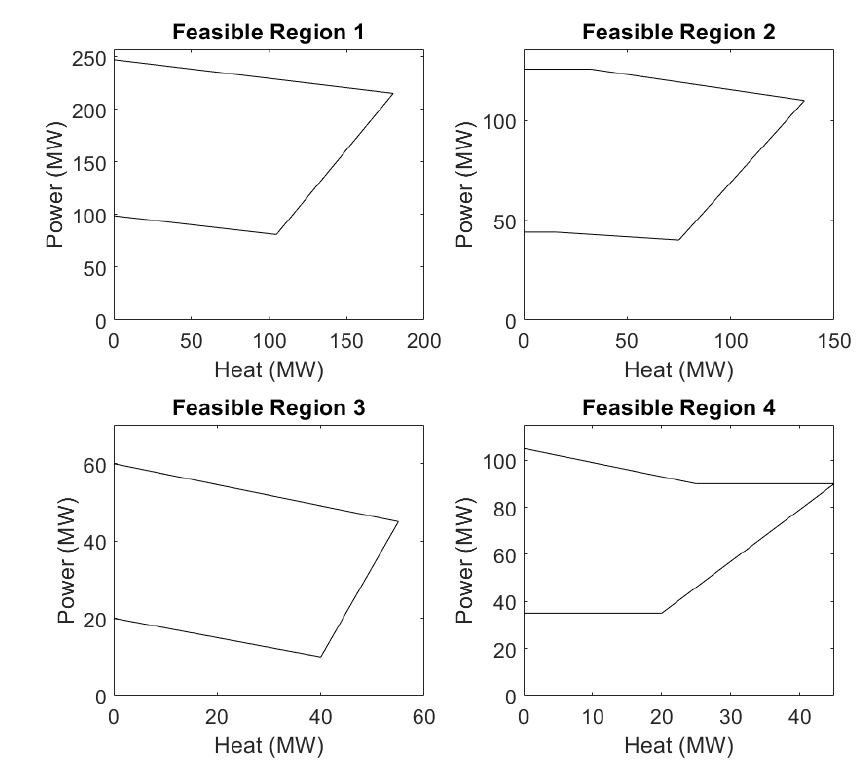
Figure 2. Several typical cogeneration feasible operating regions